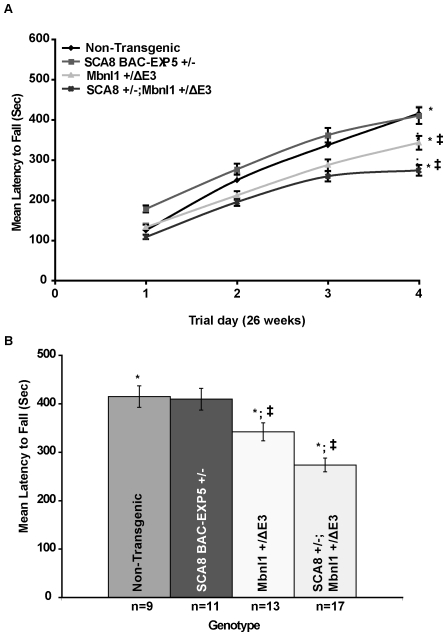
Loss of MBNL1 enhances rotarod deficits in SCA8 BAC-EXP5 mice.(A) Line plot of average latency to fall in seconds over four consecutive trial days. Individual trial day data points are the average of the last 3 trials and show a decreased latency for SCA8+/−; Mbnl1
+/ΔE3 mice that is significantly different from WT at day four. (B) Bar graph shows the mean latency to fall (Sec) for non-transgenic, singly transgenic SCA8 BAC-EXP5 (SCA8+/−). heterozygous Mbnl1 knock-out (Mbnl1+
/ΔE3) and doubly transgenic SCA8 BAC-EXP5; Mbnl1
+/ΔE3 (SCA8+/−; Mbnl1
+/ΔE3; n = 17) littermates. As previously reported for this low-copy line (SCA8 BAC-EXP5), no significant difference between non-transgenic littermates and singly transgenic SCA8+/− animals was found. Although singly transgenic Mbnl1+
/ΔE3 mice show a significant decrease in latency compared to non-transgenic (p = 0.01), doubly mutant SCA8+/−; Mbnl1+
/ΔE3 perform significantly worse than both WT and singly mutant Mbnl1+
/ΔE3 animals (p = 0.003). *and ‡ = significant differences between groups.